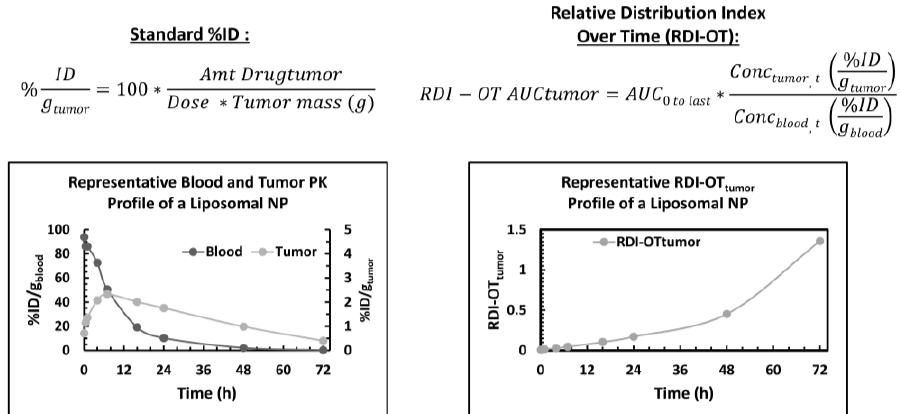
Figure 4. Calculating nanoparticle delivery efficiency using standard percent injected dose (%ID) calculation versus relative distribution index-over time (RDI-OT). The conventional calculation of tissue %ID represents the amount of drug in the target tissue at a single time point in time. However, RDI-OT is calculated for each time point within the profile, providing a new profile of the delivery efficiency of the nanoparticle over time compared to a single point in time.